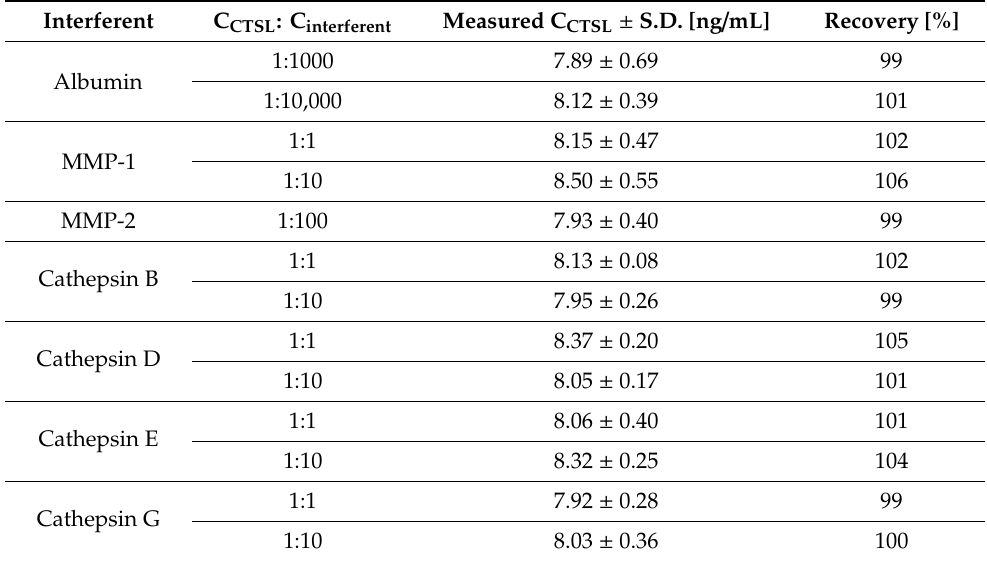
Table 1. Influence of human albumin, metalloproteinase-1 (MMP-1), metalloproteinase-2 (MMP-2), cathepsin B, cathepsin D, cathepsin E, and cathepsin G as interferents on the CTSL